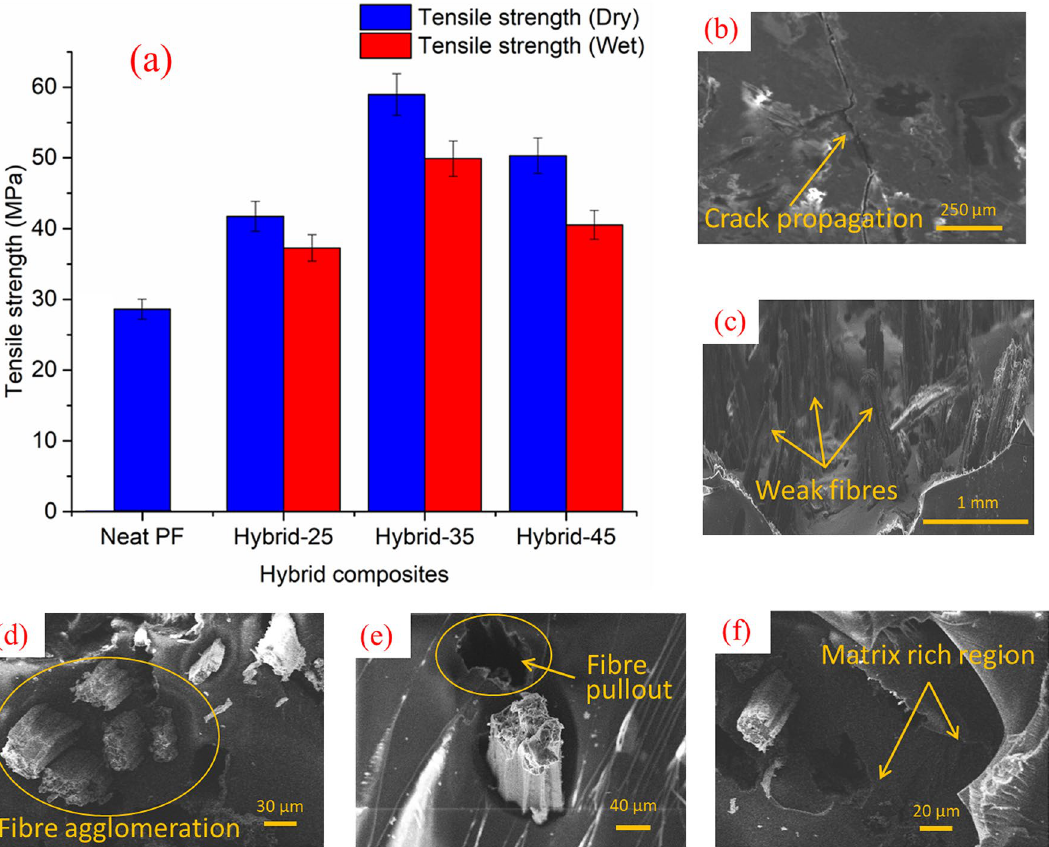
Figure 3. ( a ) Effects of water absorption on the tensile strength of CGF/AFF/PF hybrid composites based on the weight percentages of fibre. ( b , c ) SEM image of the fractured surface of the 35 wt.% hybrid composite after the tensile test (wet condition), ( d , e ) SEM image of the fractured surface of the 45 wt.% hybrid composite after the tensile test (wet condition), ( f ) SEM image of the fractured surface of the 25 wt.% hybrid composite after the tensile test (wet